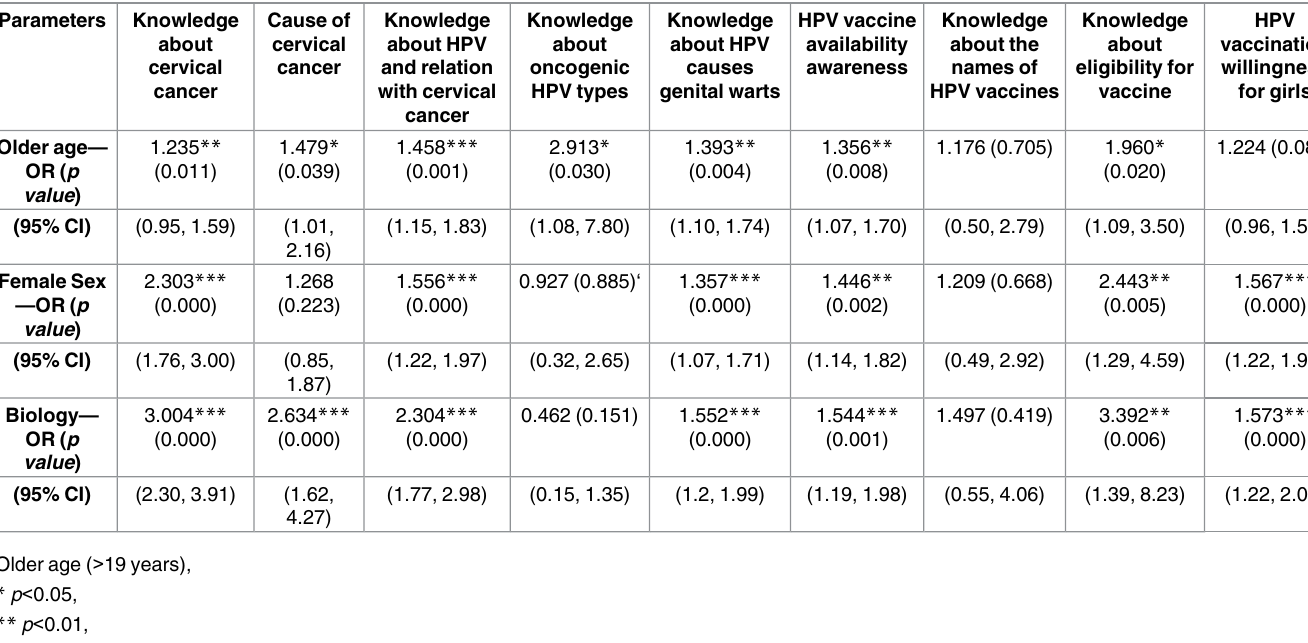
Table 4. Adjusted odds ratio (ORs) along with 95% CI for various aspects of knowledge on cervicalcancer and HPV among college